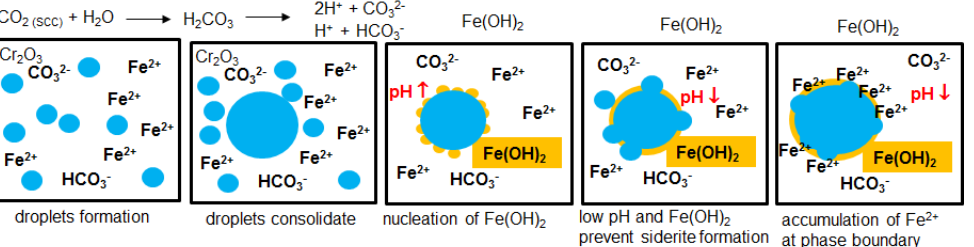
Figure 10. Schematic cross-section illustration of the first step of the corrosion procedure to form the leopard structured corrosion scale consisting of siderite FeCO 3 on 16–17% Cr high alloyed stainless steels X35CrMo17 and X5CrNi CuNb16-4.